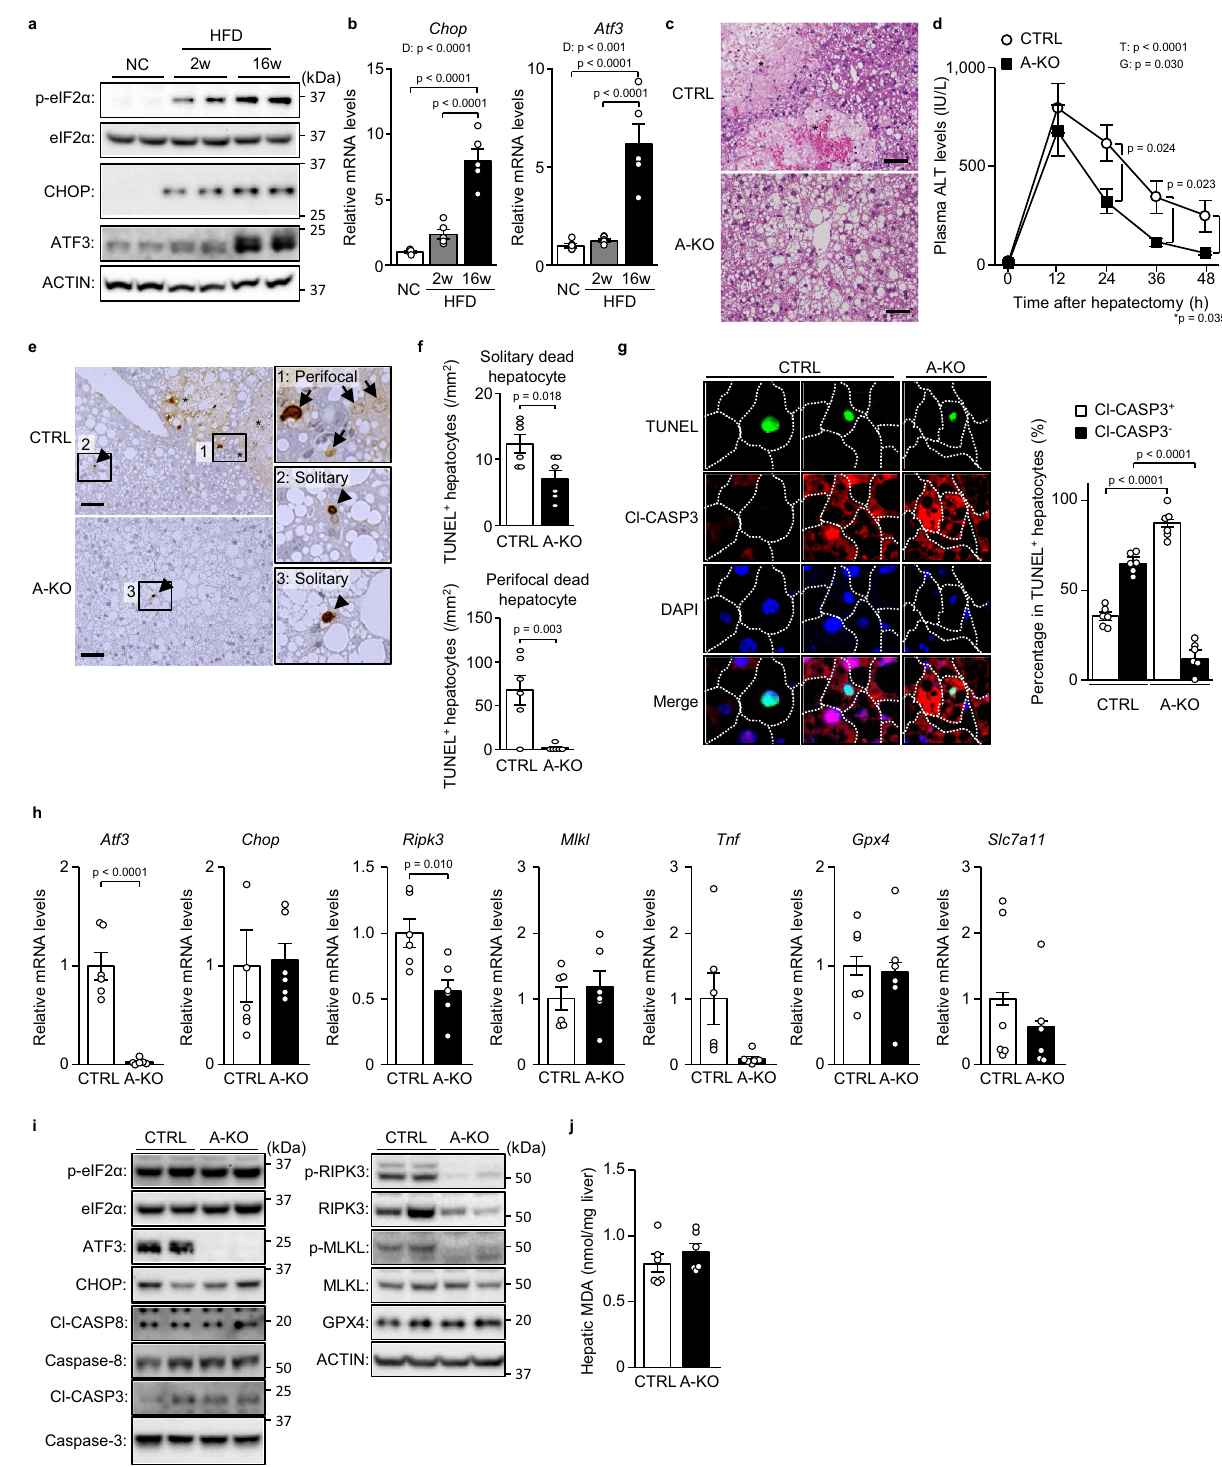
Fig. 3 | ATF3 de fi ciency prevents steatosis-induced necroptosis after hepa- tectomy. a , b Mice fed normal chow (NC) or a HFD for 2 or 16 weeks underwent partial hepatectomy. a Immunoblotanalysis. b Quantitative PCR analysis. c – j A-KO mice and littermates (CTRL) fed a HFD for 16 weeks underwent partial hepa- tectomy. c Haematoxylin-eosin staining. Scale bar, 50 μ m. Asterisks indicate hepatocellulardeath foci. d Plasma ALT levels. e TUNEL staining. Scale bar, 50 μ m. Arrowheads indicate solitary dead hepatocytes. Asterisks indicate hepatocellular death foci. Arrows indicate perifocal dead hepatocytes. f Number of TUNEL + hepatocytes de fi ned as described. g TUNEL/Cl-CASP3 double staining (left). Cl-